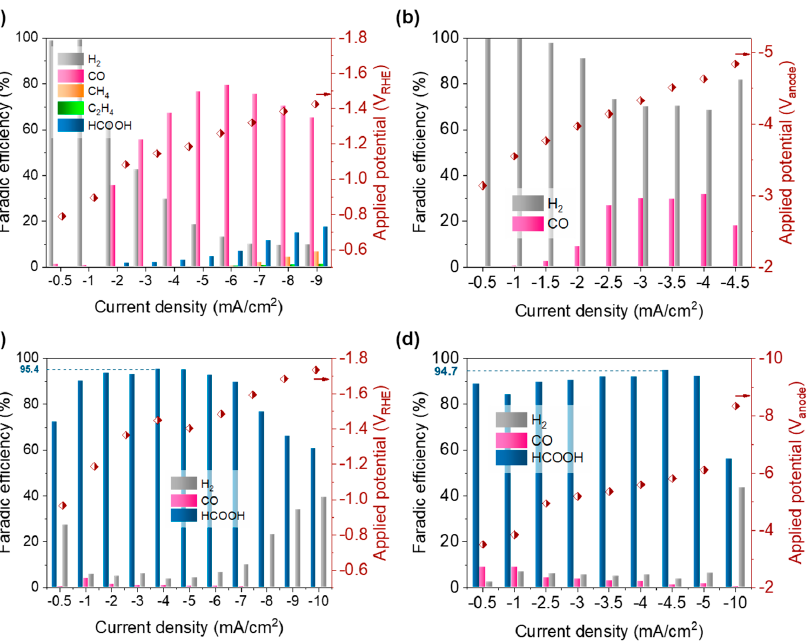
Figure 3. Comparison of CO 2 R performance. Product distributions and applied potentials against current density for ( a ) Ag in the small electrochemical cell, ( b ) Ag in the big electrochemical cell, and ( c ) In in the small electrochemical cell, and ( d ) In in the big electrochemical cell. For all the measurements, the electrolyte is 0.1 M aqueous solution of KHCO 3 . The volume of catholyte in the small electrochemical cell is ~2 mL with a CO 2 flow rate of 5 sccm. The volume of catholyte in the big electrochemical cell is ~400 mL. The CO 2 flow rate of 100 sccm is chosen to ensure a similar mass transfer environment as the small electrochemical cell.